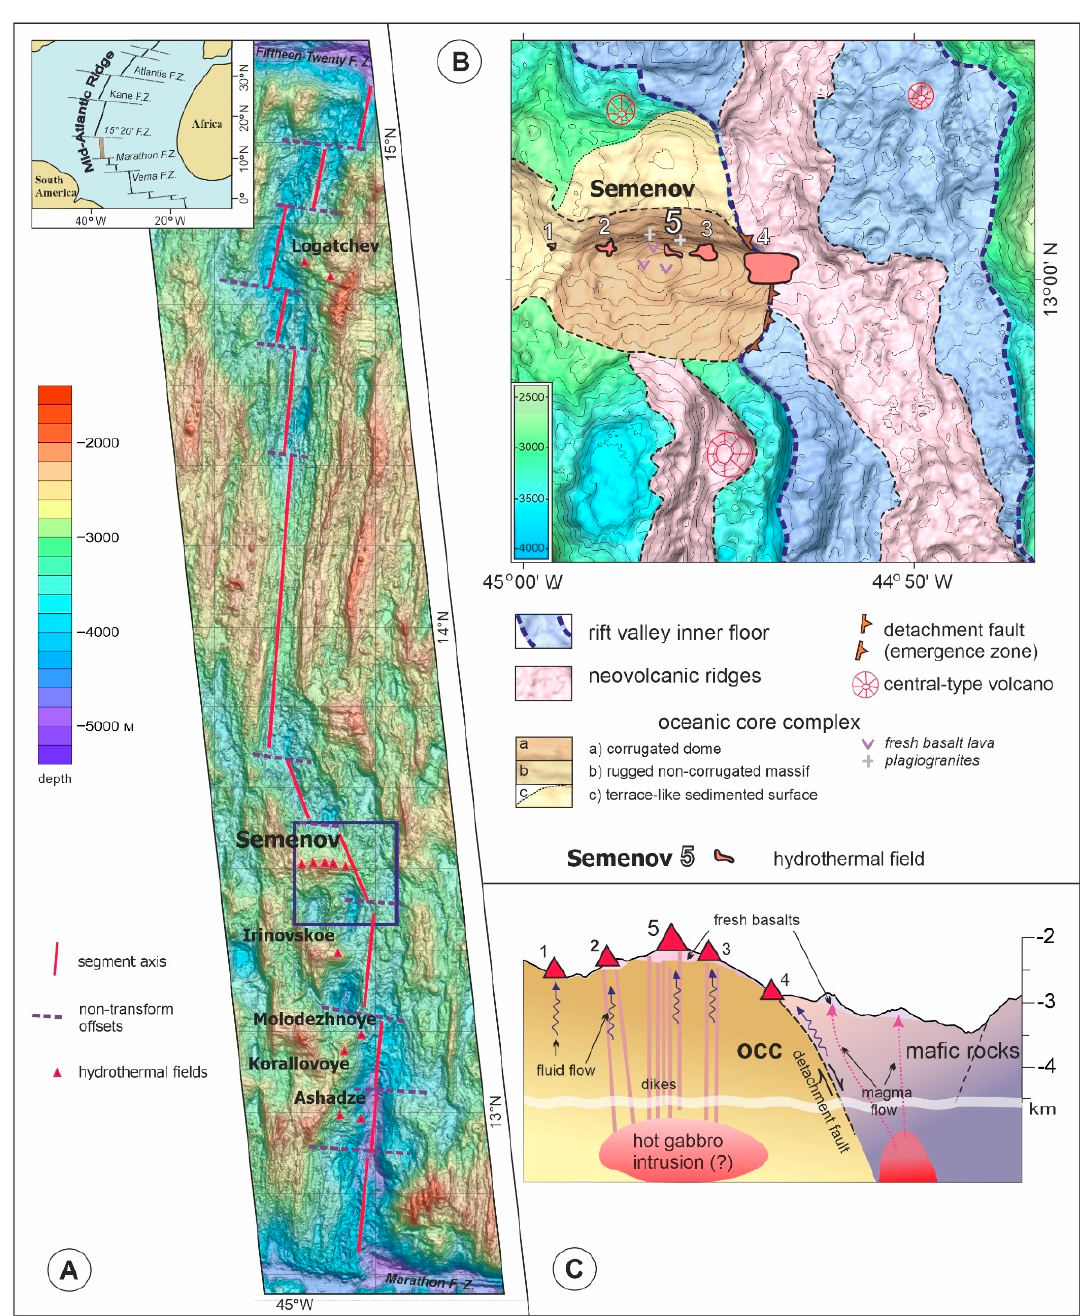
Figure 1. Semenov hydrothermal area. ( A ) The regional bathymetry of the MAR segment between 15–20 and Marathon fracture zones and the location of the hydrothermal fields. The box corresponds to the area of ( B ). ( B ) Morphostructural setting of the Semenov hydrothermal fields. ( C ) Interpretative cross-section of the MAR rift valley in the Semenov cluster (modified from Pertsev et al. [1]); vertical exaggeration 3:1.